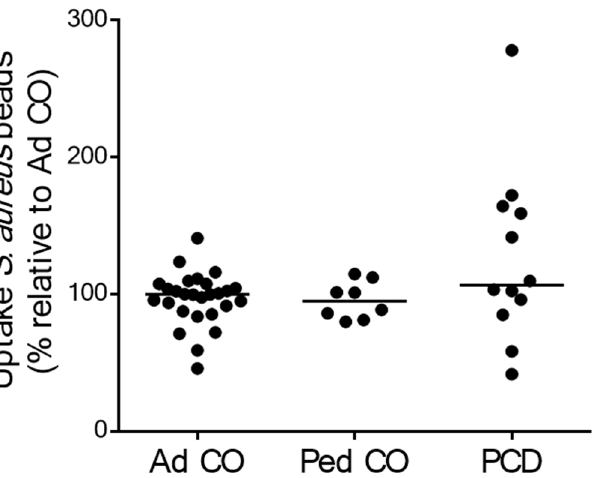
Figure 5. The phagocytic capacity of blood PMNs from patients with PCD is not significantly different from that of PMNs from healthy controls. The phagocytic capacity of PMNs from patients with PCD (PCD, n = 12 [10 pediatric and 2 adult]), age-matched healthy pediatric controls (Ped CO, n = 8) and healthy adult controls (Ad CO, n = 27) was measured by flow cytometry. The uptake of S. aureus -labeled beads by PMNs isolated from healthy children and patients was expressed relative to the uptake by PMNs isolated from the corresponding reference Ad CO (%). No significant difference in phagocytosis was detected between PMNs from patients with PCD and either of the healthy control groups (Mann Whitney U-test).